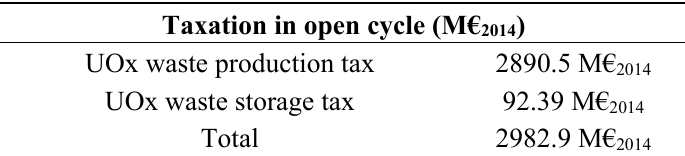
Table 3. Taxation in open cycle for all period of study .